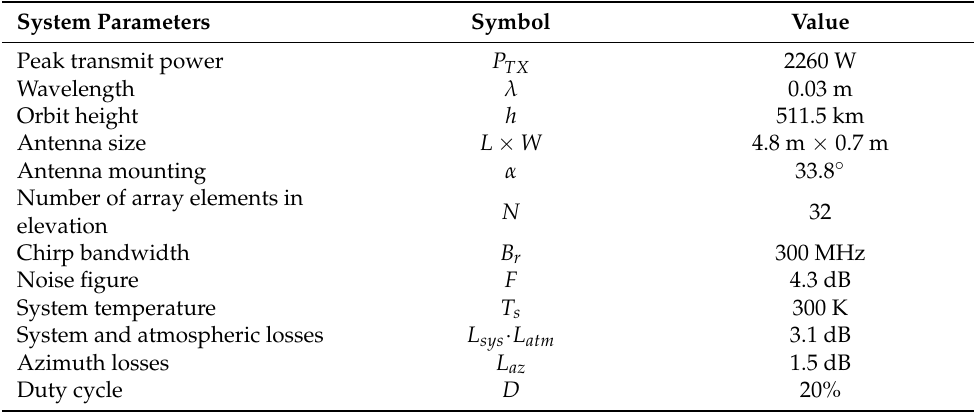
Table 2. TerraSAR-X system parameters.